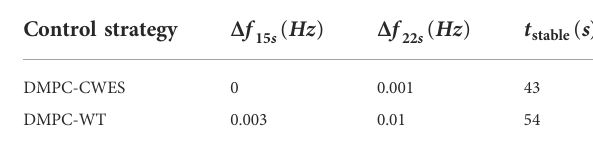
TABLE 4 Test results in case